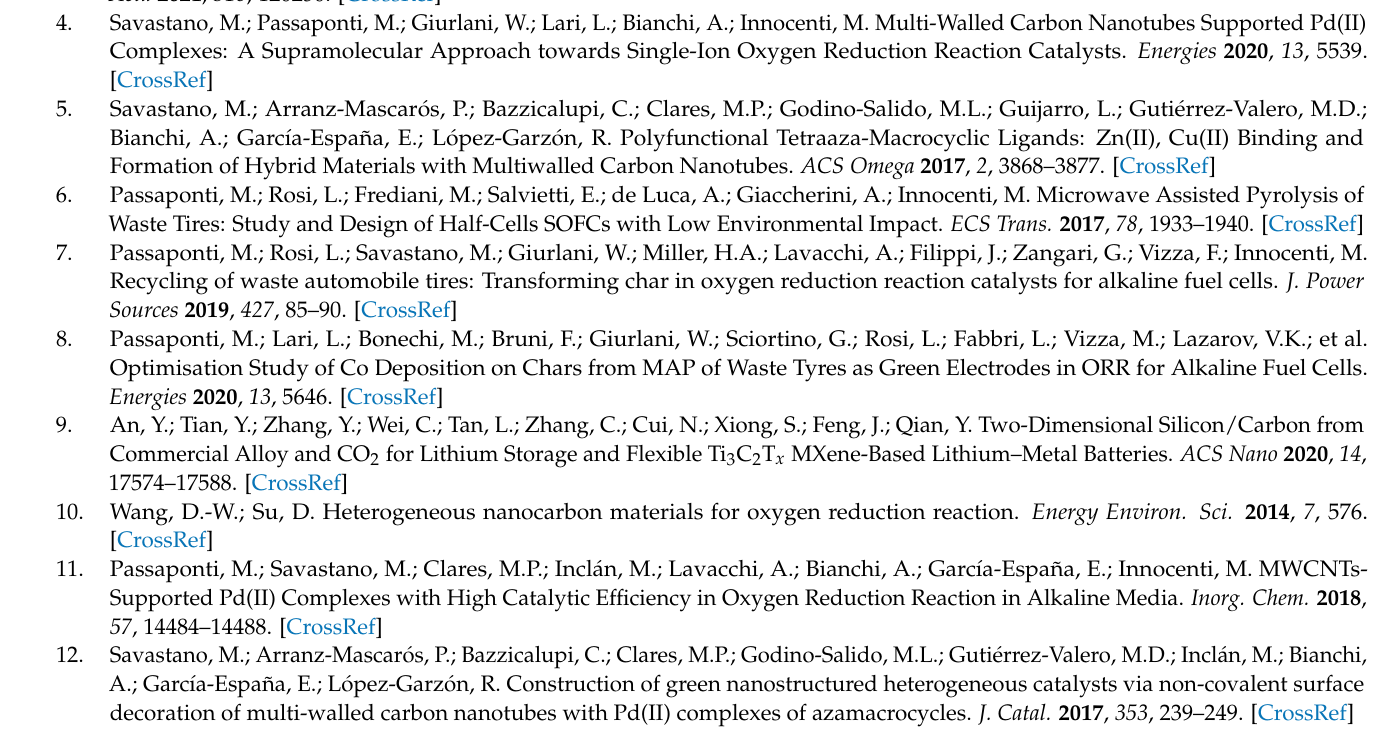
Figure S1: Molecular Orbital energies diagram for HL1 catalyst. Figure S2: Molecular Orbital energies diagram for HL1